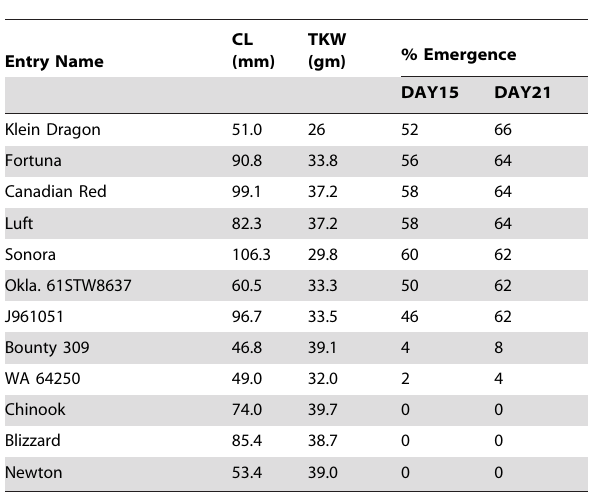
Table 1. Coleoptile length (CL), thousand kernel weight (TKW) and emergence percentage of selected cultivars in the world wheat collection having maximum and minimum emergence from deep planting on 15 and 21 days after